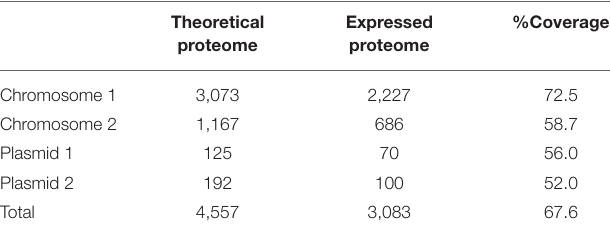
TABLE 2 | Comparison of the theoretical (coding sequences) and expressed proteome. Theoretical Expressed proteome